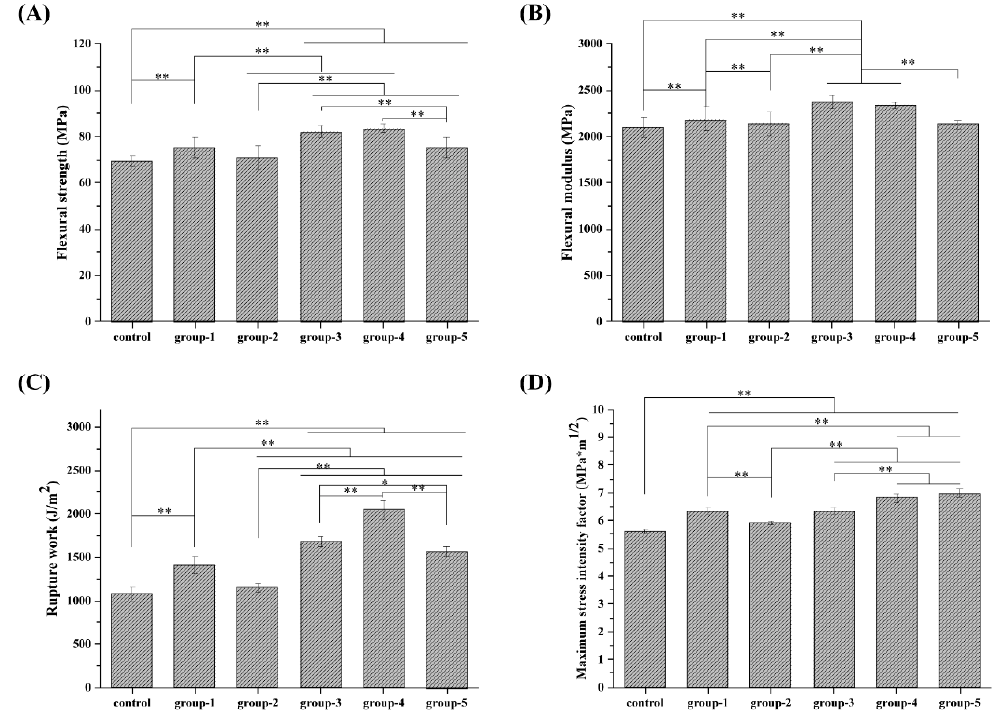
Figure 3. Mechanical properties of PMMA composites resins: ( A ) flexural strength; ( B ) flexural modulus; ( C ) rupture work; and ( D ) maximum stress intensity factor.